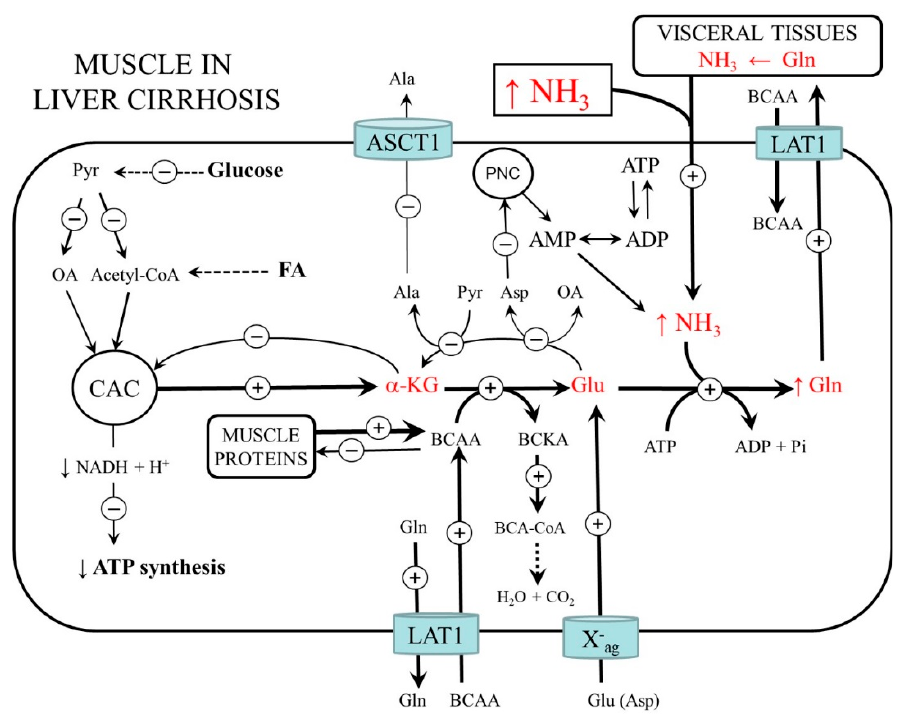
Figure 6. Ammonia and amino acid metabolism in cirrhosis. Increased ammonia detoxification to glutamine in muscles results in BCAA deficiency, cataplerosis (drain of α -KG from CAC), and mitochondrial dysfunction. Due to the limited activation of glycolysis and mitochondrial dysfunction, the detoxification of ammonia is less efficient than during exercise. ASCT1 (alanine, serine, cysteine, and threonine carrier 1); BCAA, branched-chain amino acids; BCA-CoA, branched-chain acyl-CoA; BCKA, branched-chain keto acids; CAC, citric acid cycle; FA, fatty acids; LAT1 (large neutral amino acid transporter 1); OA, oxaloacetate; X -ag (transporter for aspartate and glutamate).